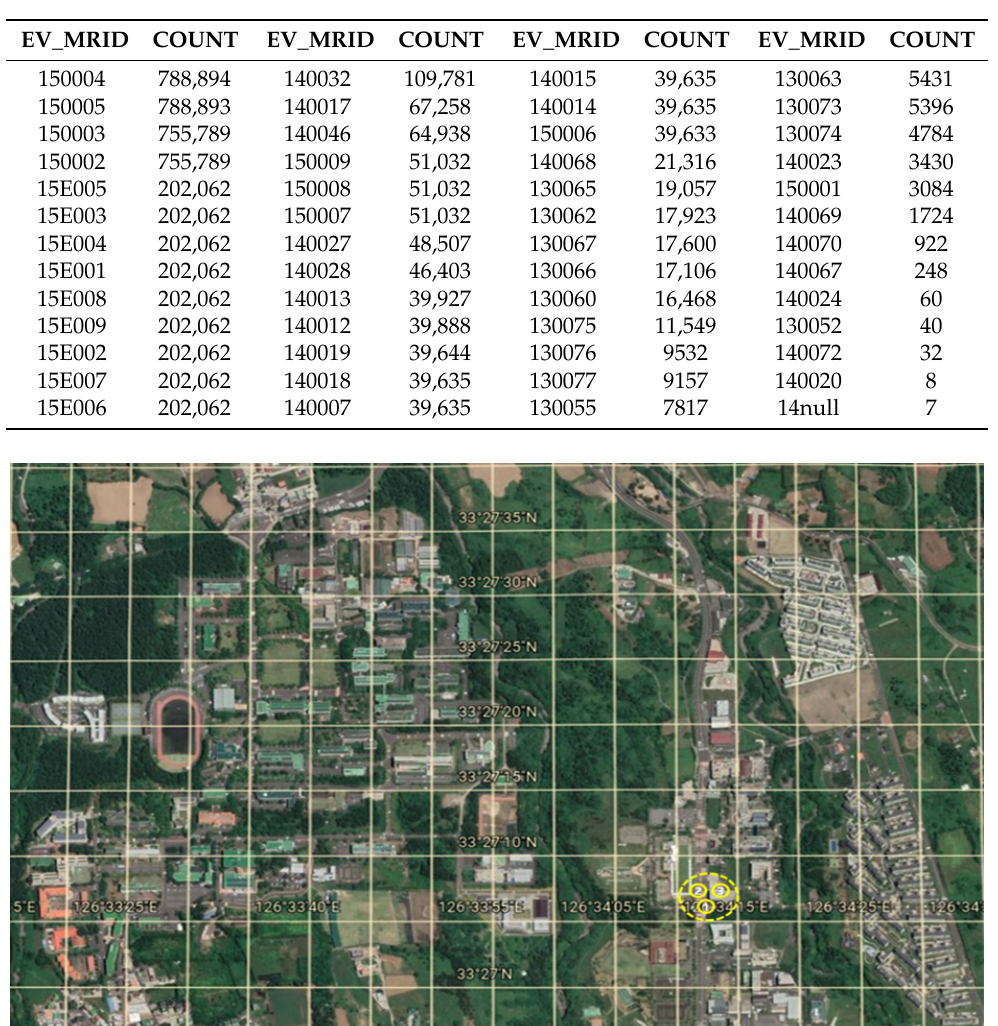
Table 2. Central and related tourist attraction information of Visit Korea data lab.